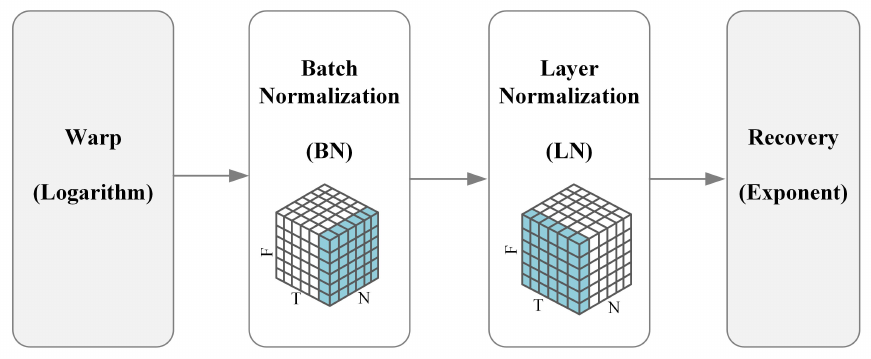
Figure 10. Two layer normalization.